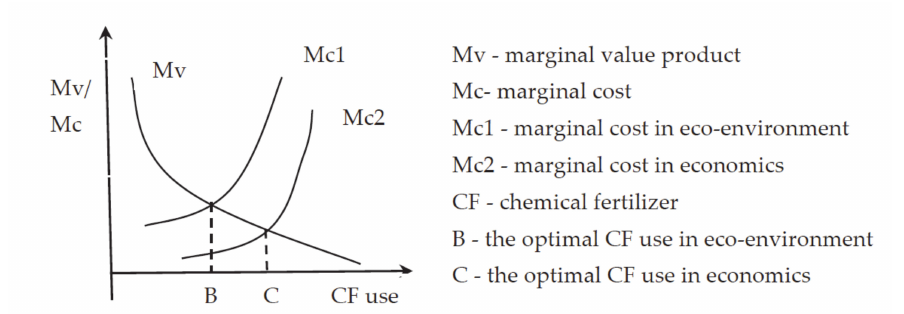
Figure 2. Optimal applications of CFs in economics and the